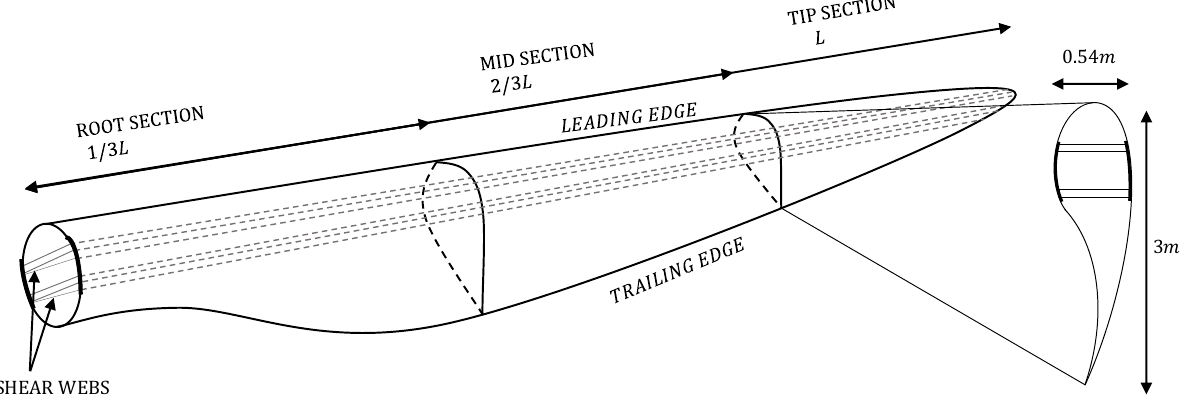
Figure 1. Dimensions of a sample 61.5 m Wind Turbine Blades (WTB), using the NREL 5MW blade as a reference [67].